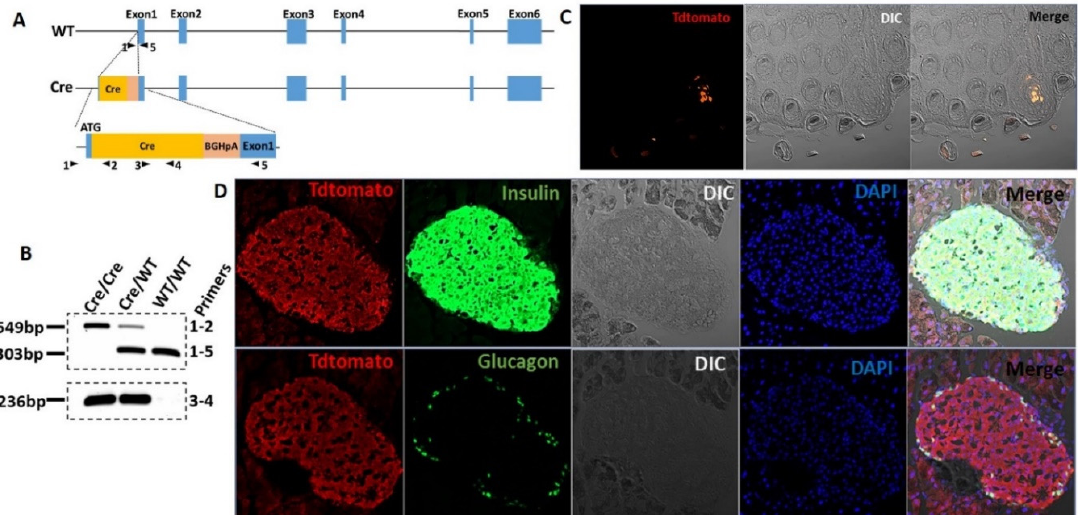
Figure 1. The T1R2 sweet taste receptor is expressed in beta ‐ cells of mouse islets. ( A ) Construct development and generation of T1r2 ‐ Cre mice. ( B ) Genotyping of T1r2 ‐ Cre mice using two separate PCR reactions. ( C ) Tdtomato expression in taste buds of the tongue in T1r2 ‐ Cre:Tdtomato ‐ fl/fl mice using fluorescent microscopy of endogenous Tdtomato. Differential interference contrast (DIC). ( D ) Co ‐ expression of Tdtomato with glucagon or insulin in islets from T1r2 ‐ Cre:Tdtomato ‐ fl/fl mice using immuno ‐ fluorescent microscopy. Scale bar: 20× magnification.